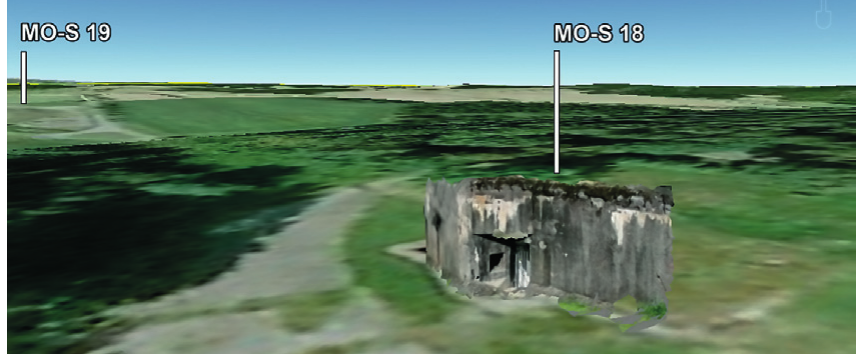
Fig. 9. MO-S 18 in Google Earth